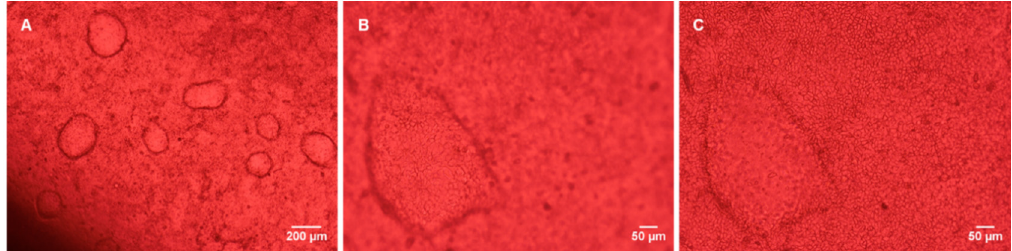
Figure 5. Caco-2 monolayer in the bioreactor at culture day 11. ( A ) 4× magnification; ( B , C ) 10× magnification (at different focal planes).